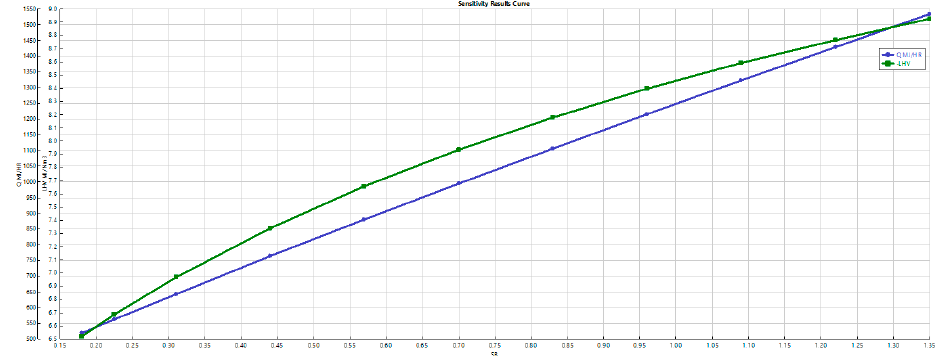
Figure 9. Gasifier heat demand vs. S/B considering hazelnut shells.